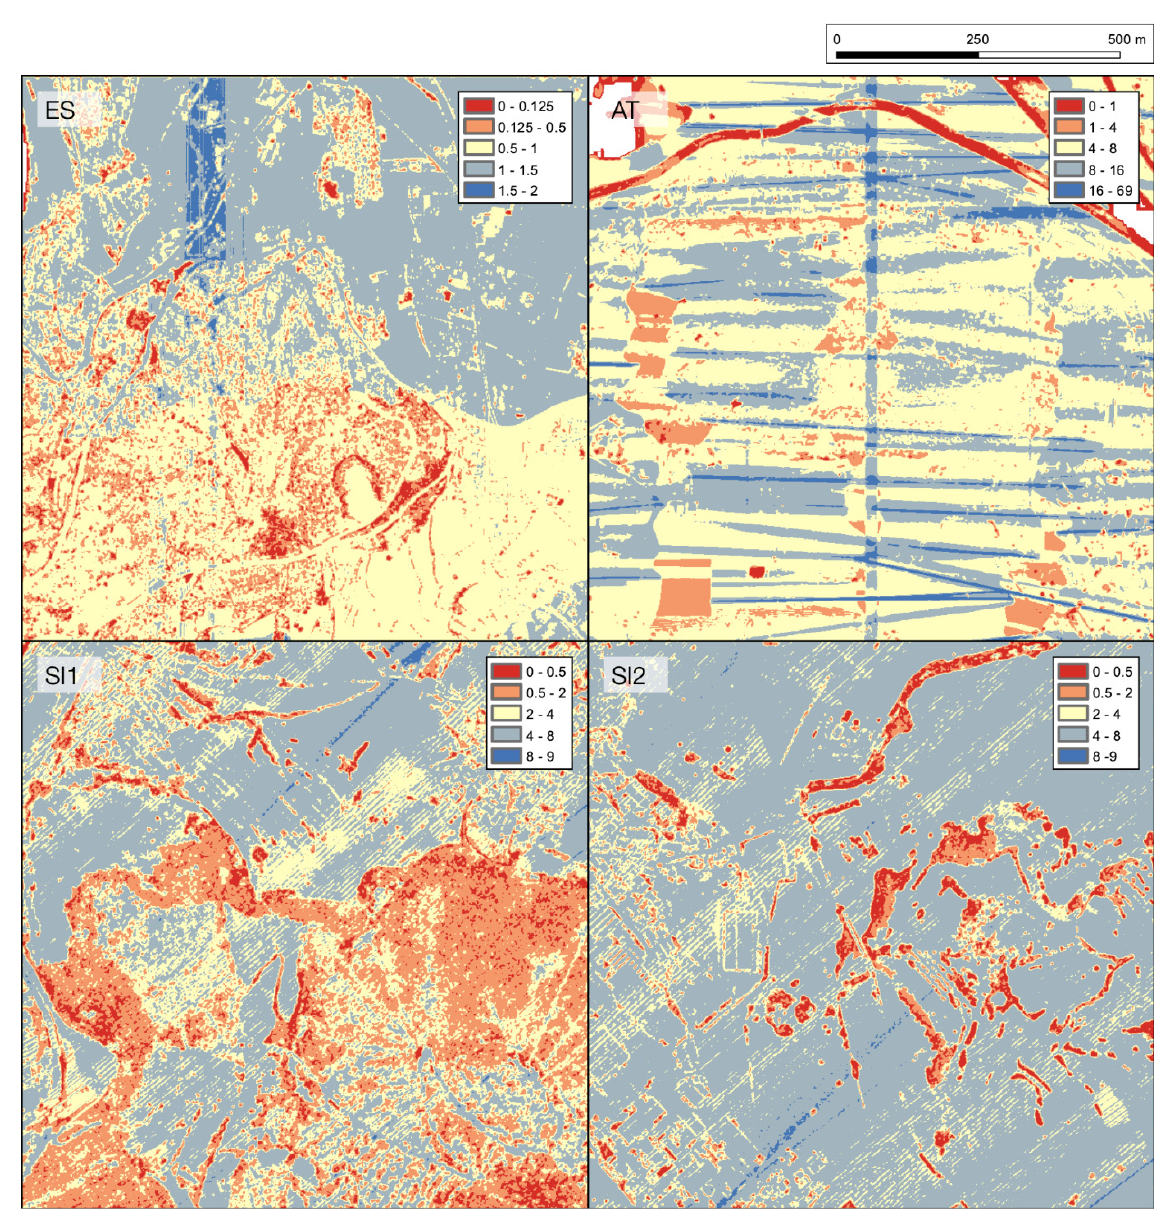
Figure 7. Ground point density for each test site (in pnts/m 2 ).